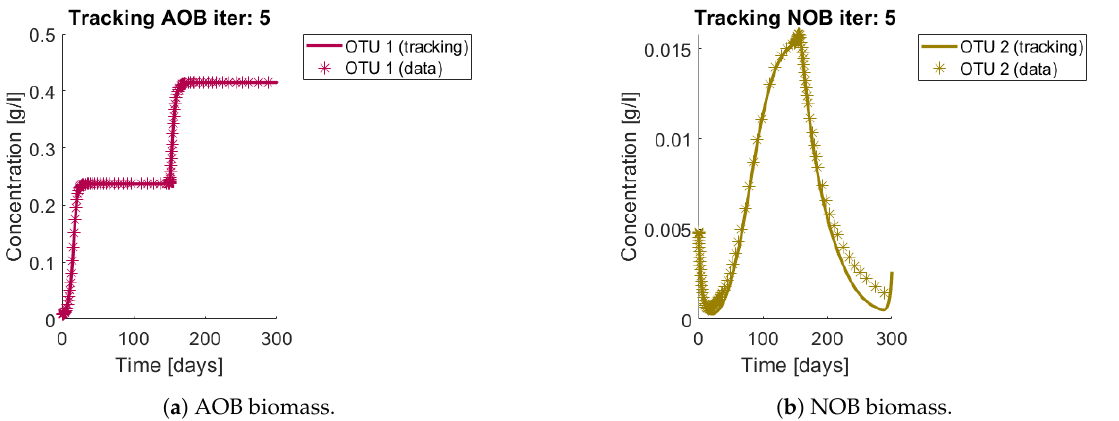
Figure 7. Asterisks represent the synthetic data, while the continuous lines represent the method’s output. The method reconstructs a continuous trajectory from the synthetic data.